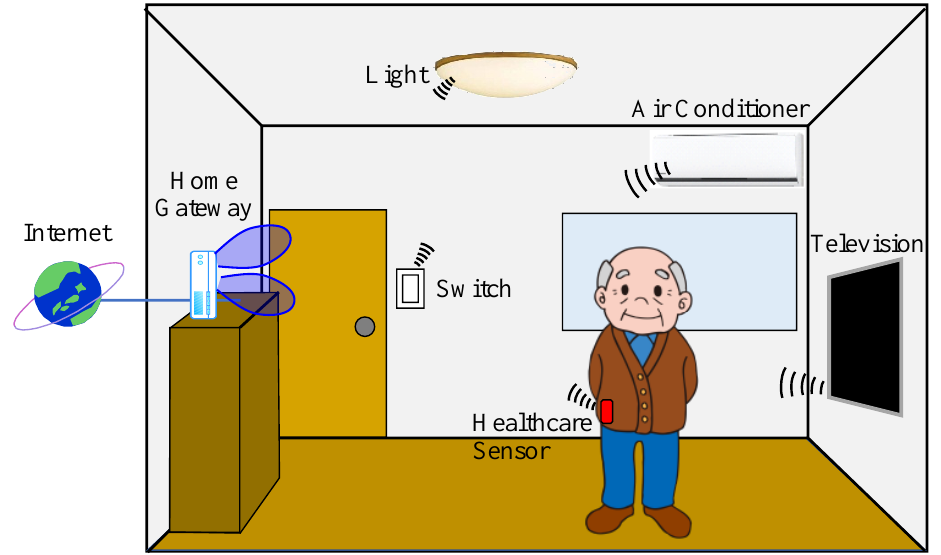
Figure 1. Conceptual illustration of a smart home.